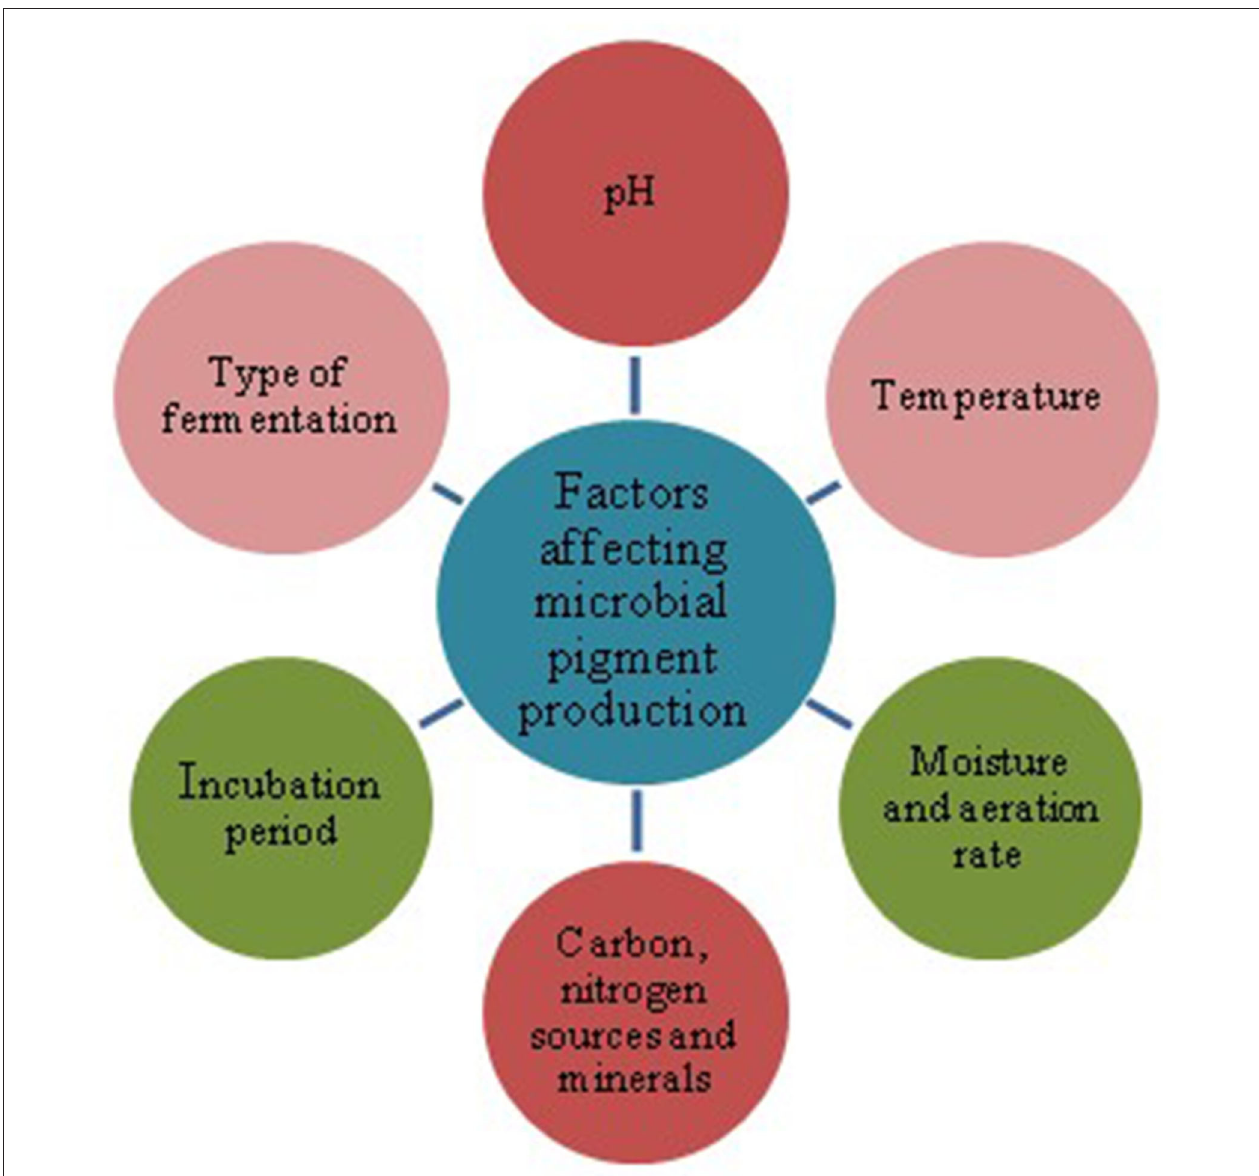
FIGURE 2 | Different factors affecting the production of microbial